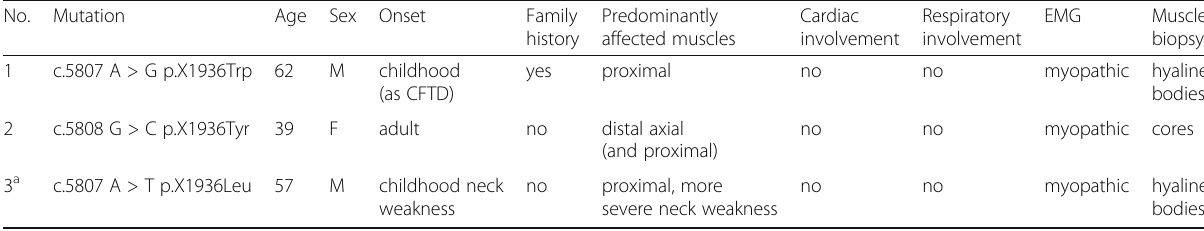
Table 1 Clinical and histopathological features of the two reported stop-loss mutations and our case No.